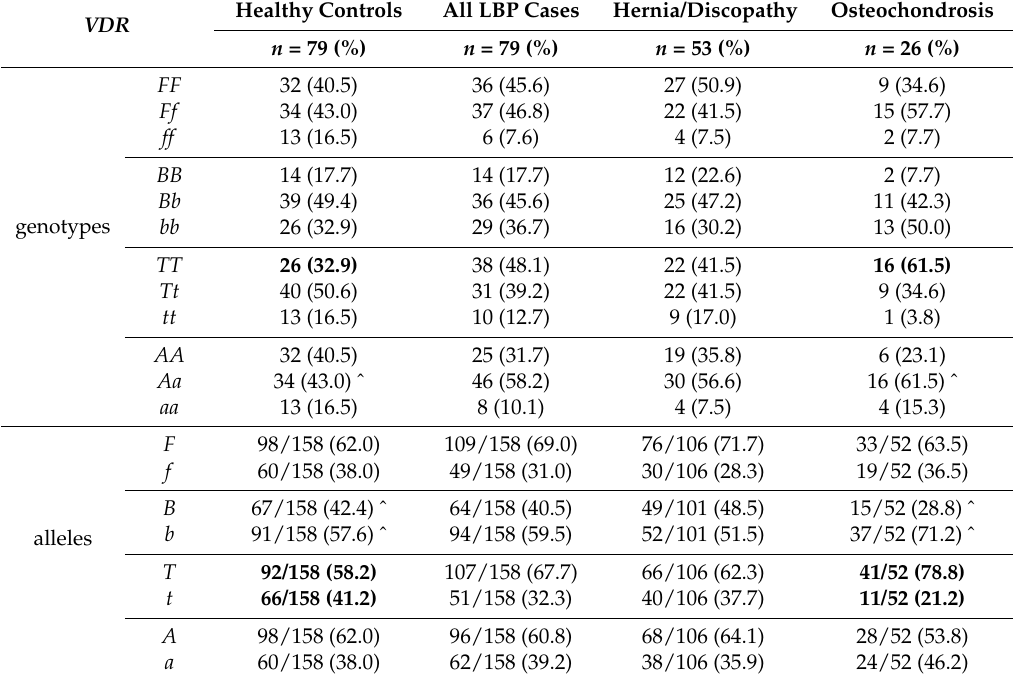
Table 1. Frequencies of vitamin D receptor ( VDR ) genotypes and alleles in healthy controls, all lower back pain (LBP) cases, and two different pathological LBP subgroups (hernia/discopathy without osteochondrosis and osteochondrosis positive